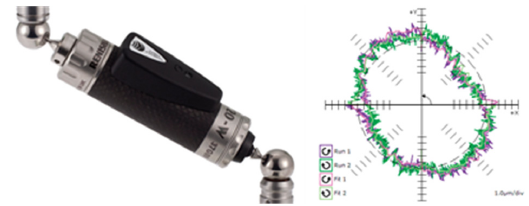
Figure 12. Renishaw QC20-W ballbar and typical test results [25].